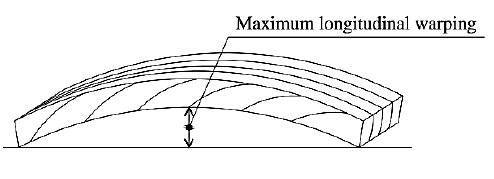
Figure 1: Method of measure longitudinal warping